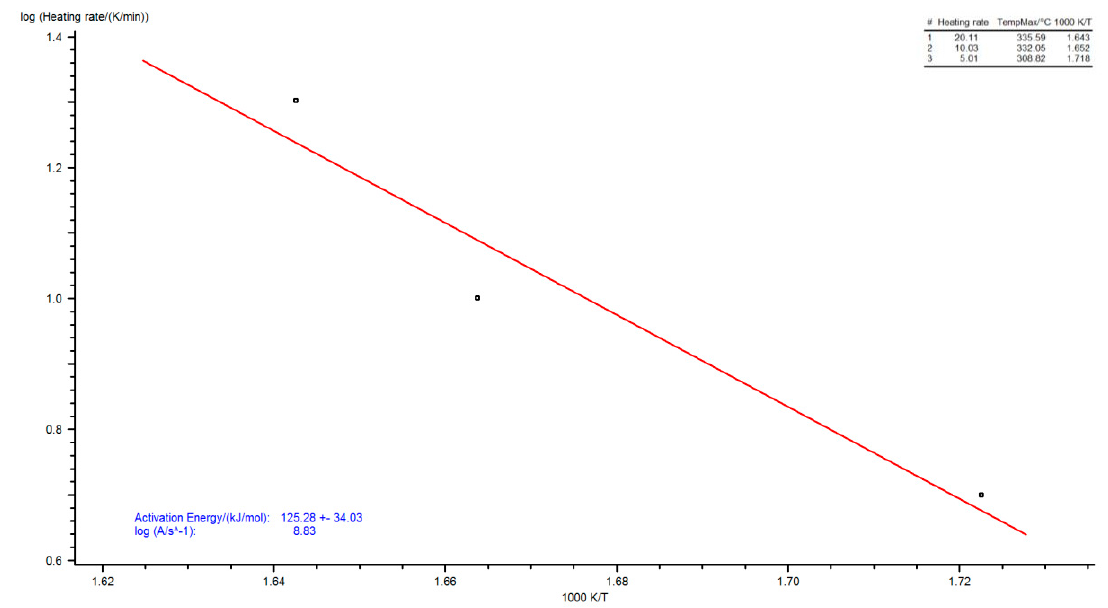
Figure A2. TG curves for three heating rates recorded for a maize straw sample.